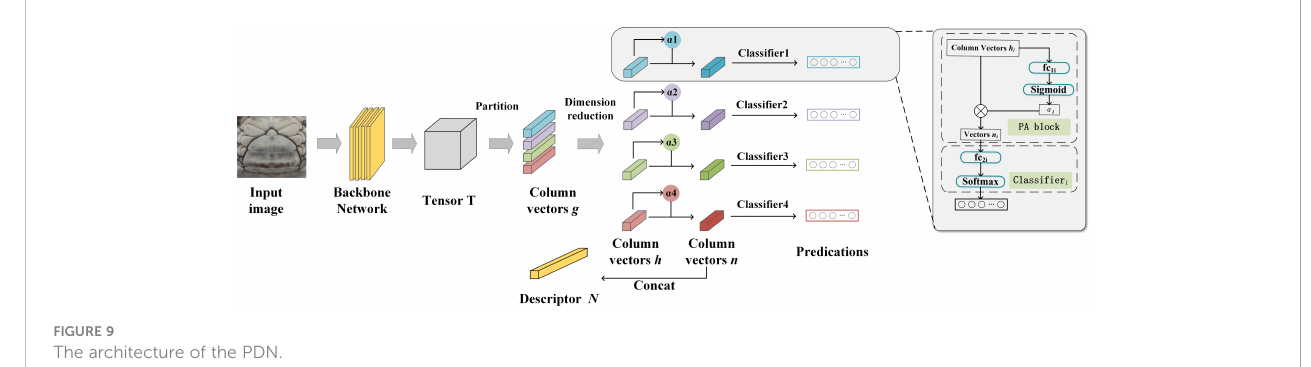
FIGURE 9 The architecture of the PDN.